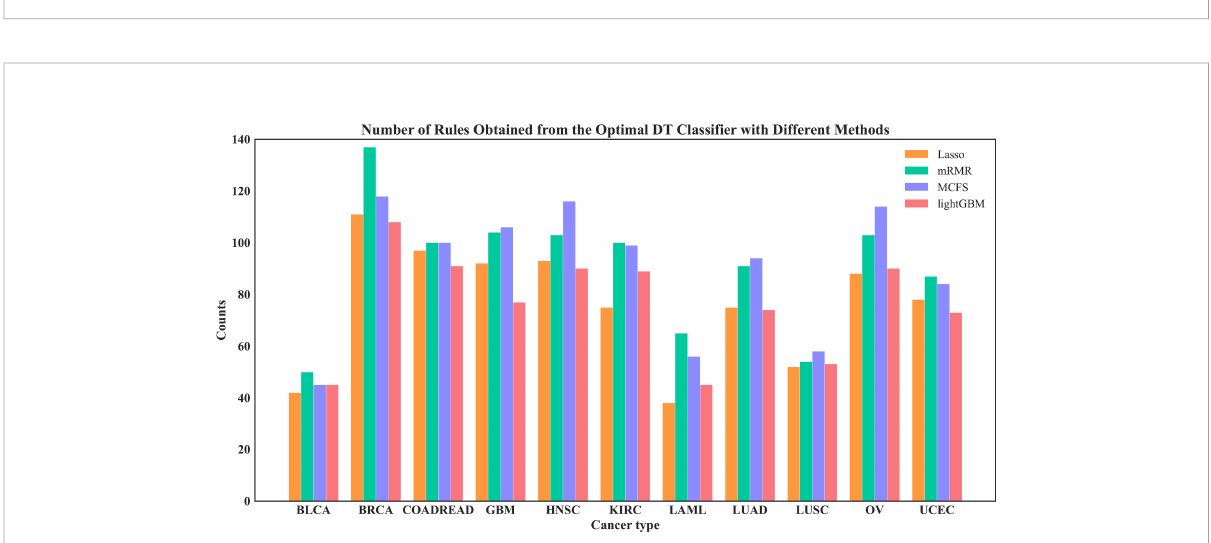
FIGURE 10 Number of rules under each cancer type obtained by the four optimal DT classi fi ers on four feature lists.